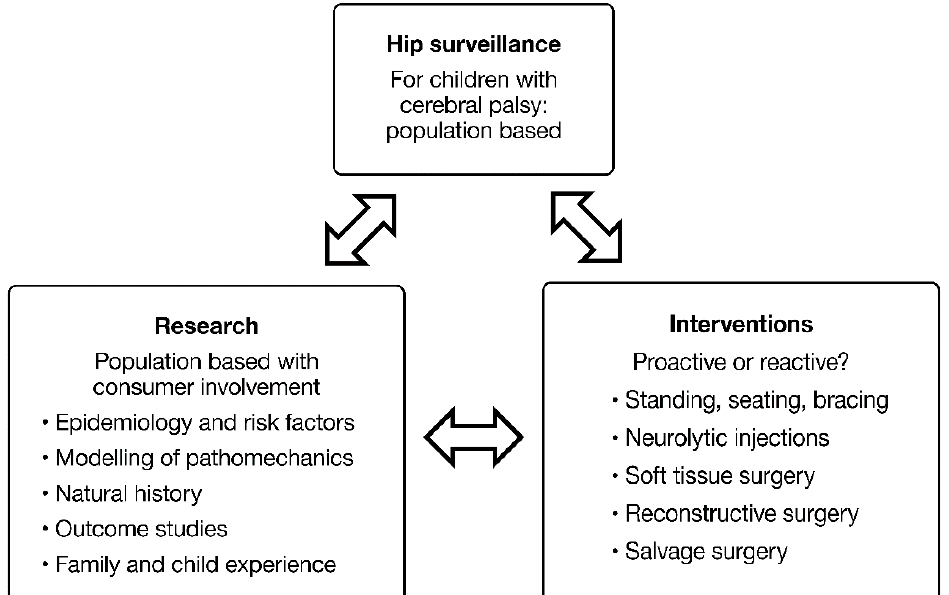
Figure 1. Hip surveillance, research and interventions. Copyright Bill Reid, Pam Thomason and Kerr Graham, RCH Melbourne. Hip surveillance for children with CP improves the knowledge